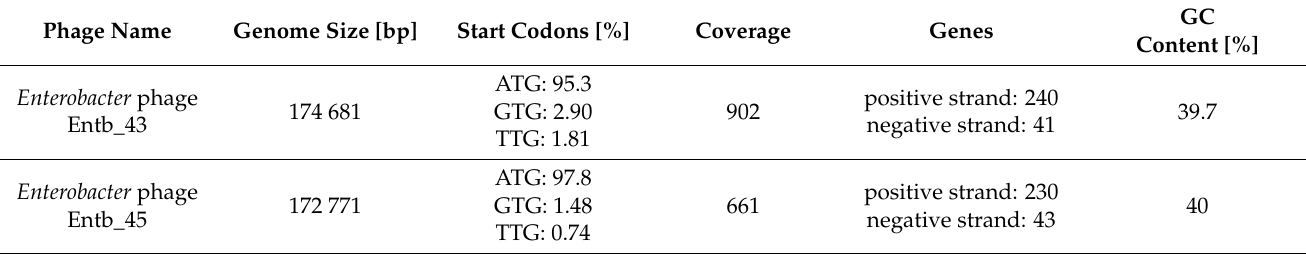
Table 7. Basic features of sequenced